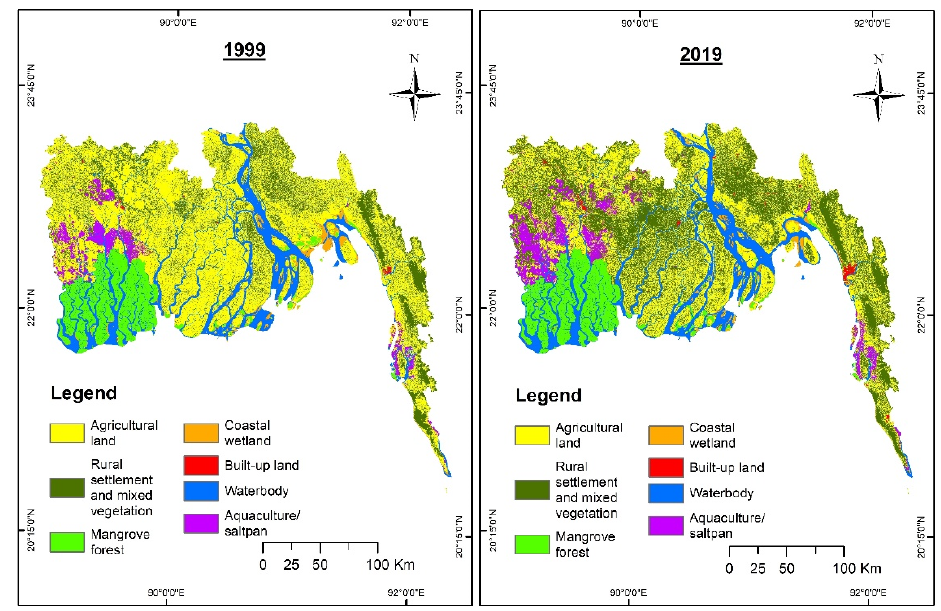
Figure 3. Land use land cover maps of the CRB in 1999 and